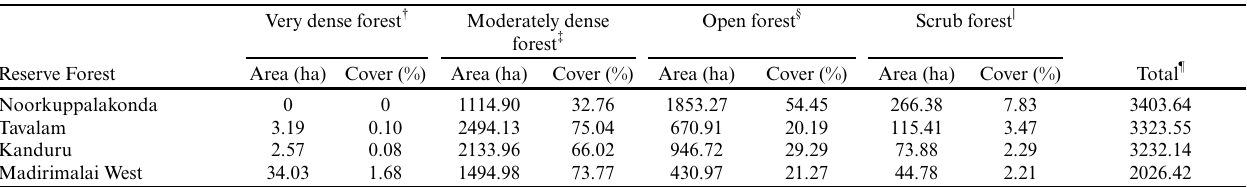
Table 1. Forest cover in the four Reserve Forests. Source: Government of Andhra Pradesh (2014). Very dense forest † Moderately dense Open forest § forest ‡ Reserve